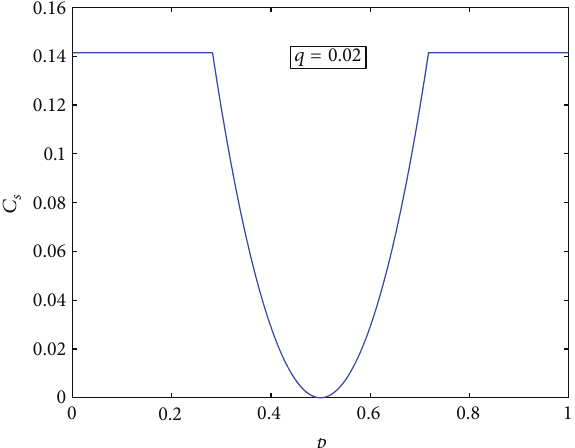
Figure 9: When 𝑞 = 0.02 , the secrecy capacity of the model of Figure 6 is with causal channel state